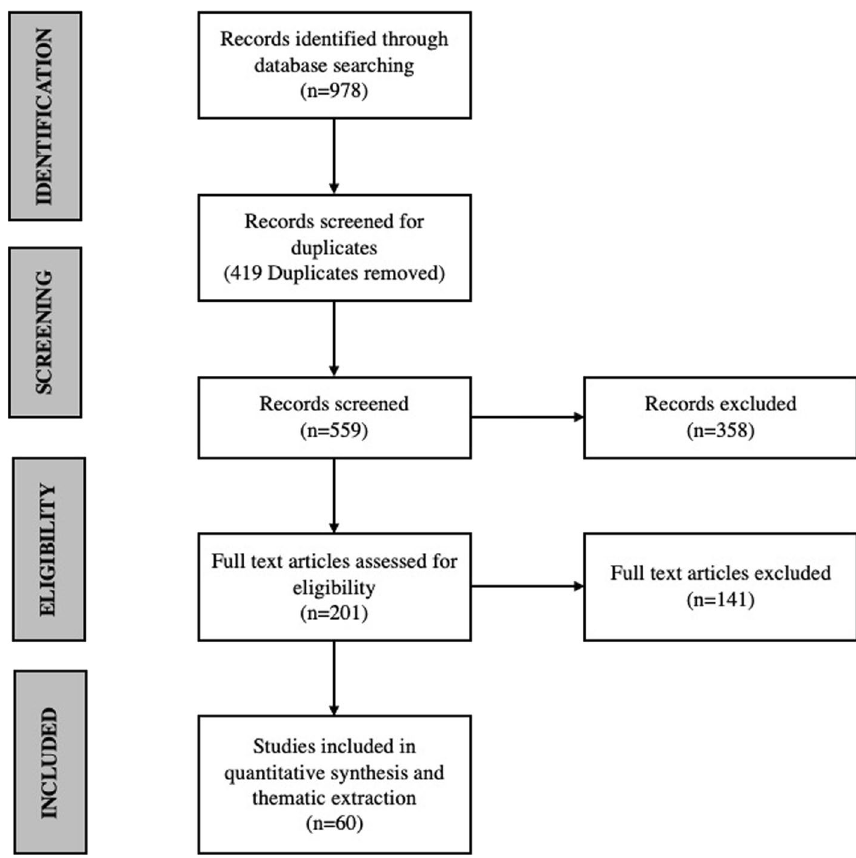
Fig. 1 PRISMA (preferred reporting items for systematic reviews and